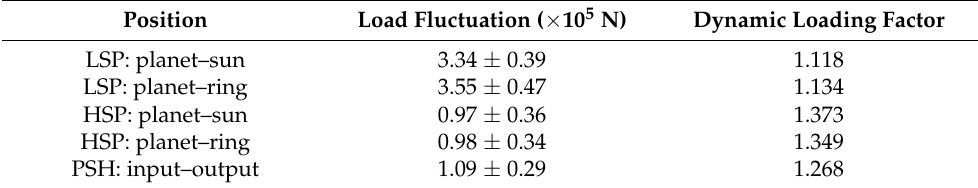
Table 9. Dynamic loading factors of the gear